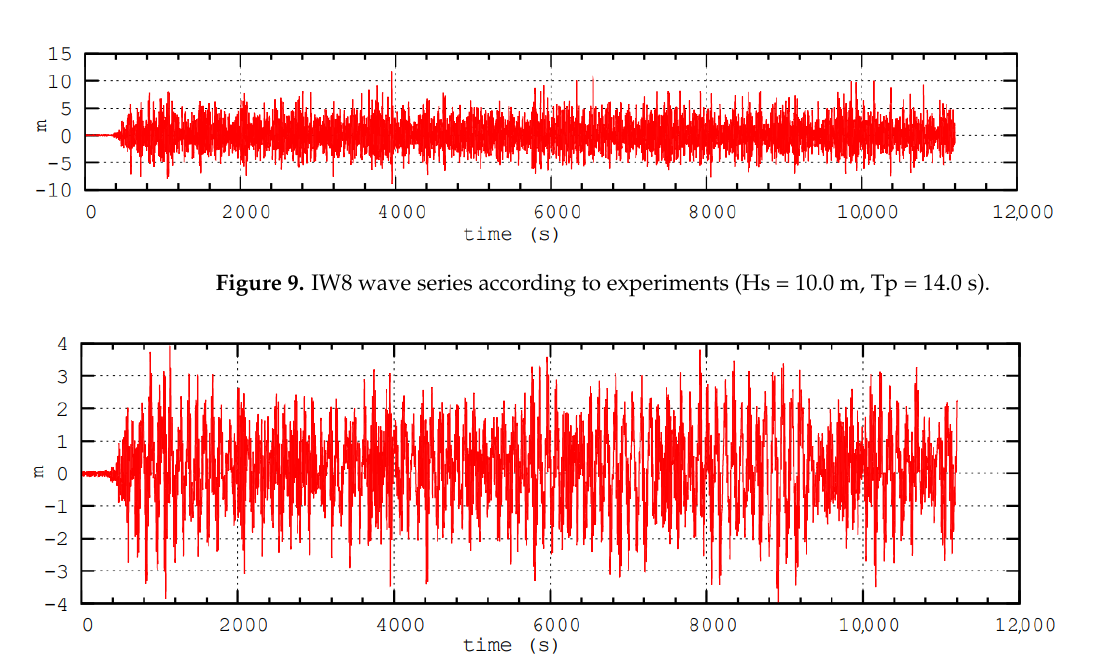
Figure 10. Surge response to IW8 according to experiments.